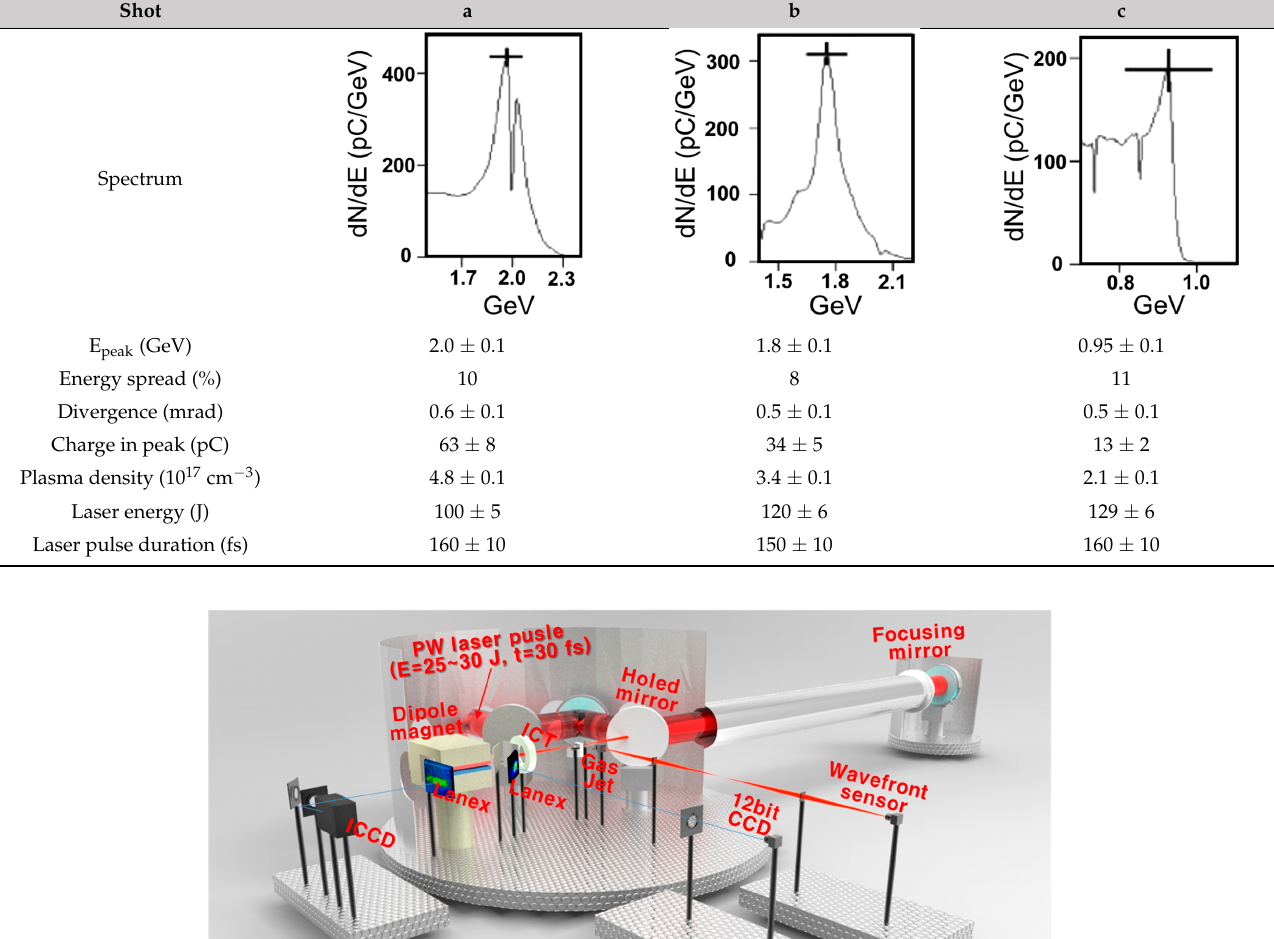
Table 1. Experimental results for three different laser shots from the Texas PW laser [11]. Reproduced with permission from [Xiaoming Wang], [ Nat. Commun ]; published by [macmillan Publishers Limited], [2013]. b c